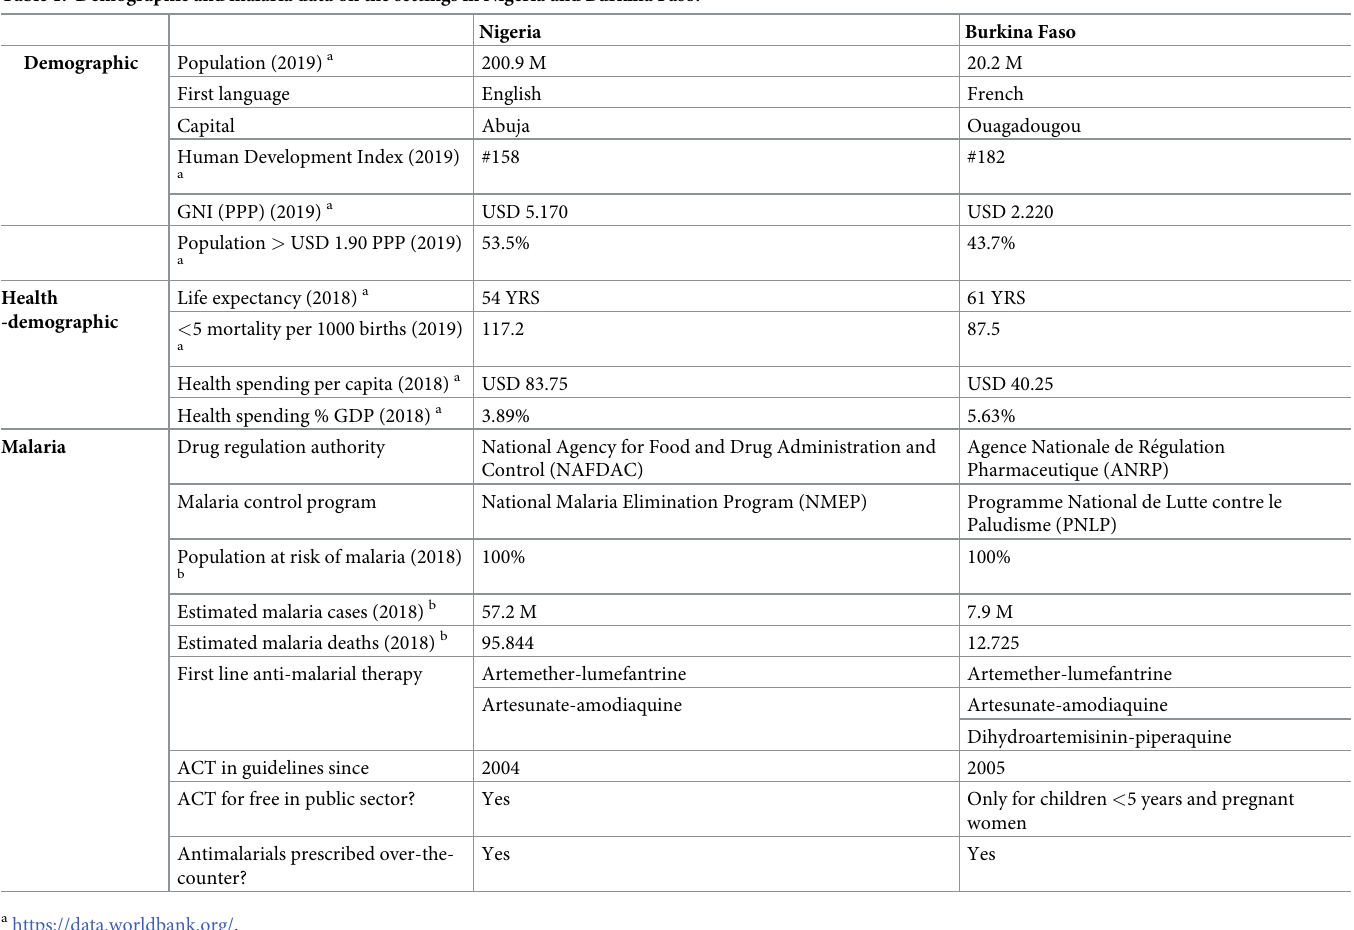
Table 1. Demographic and malaria data on the settings in Nigeria and Burkina